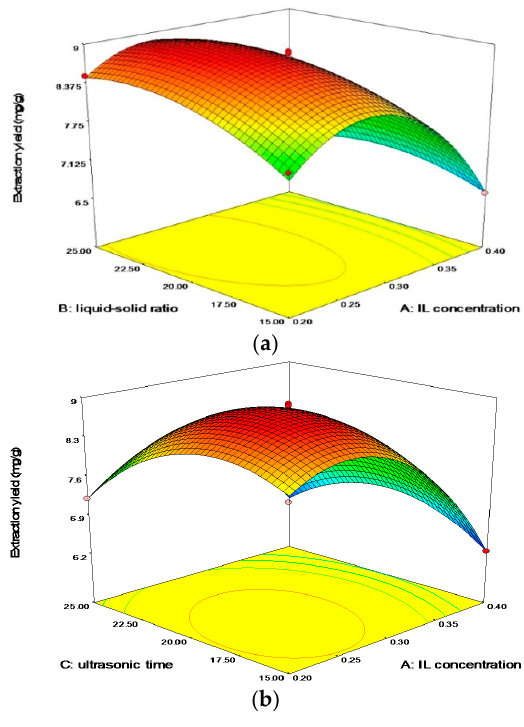
Figure 4. Cont. Figure 4.